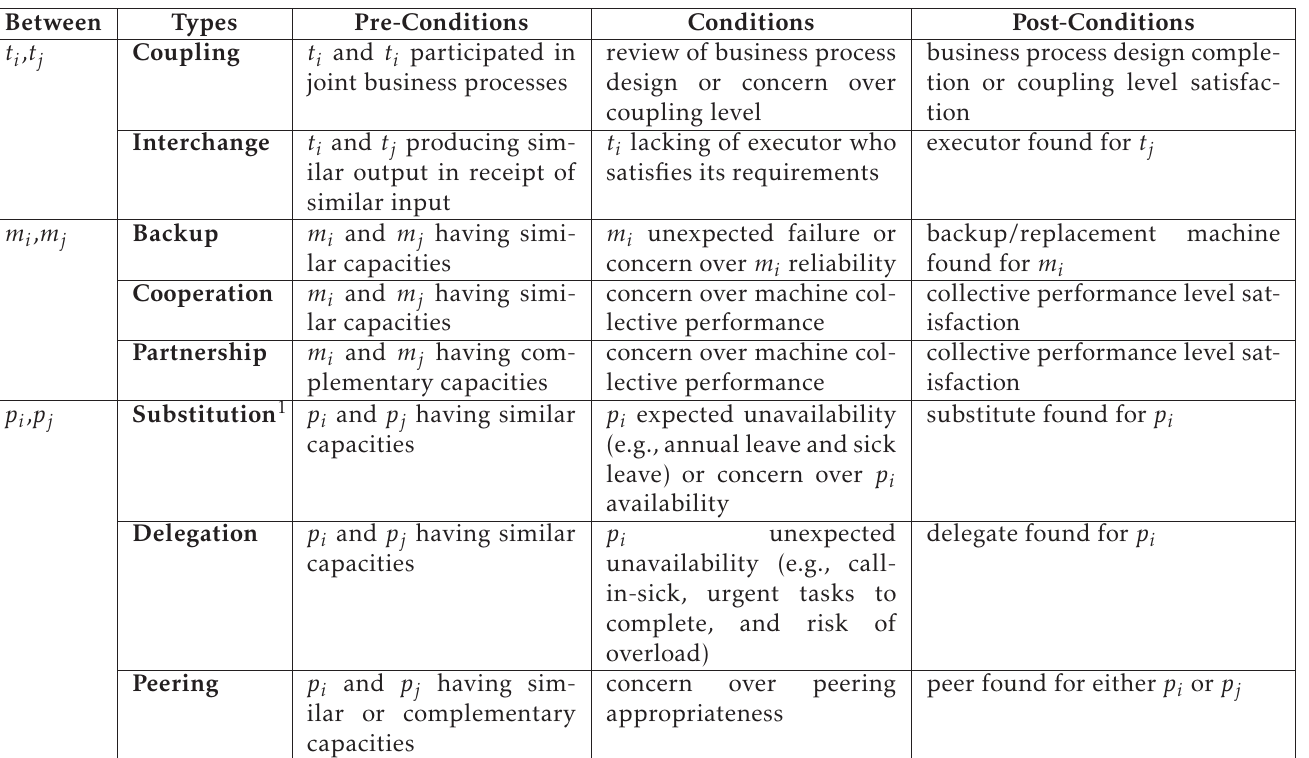
Table 2. Summary of social